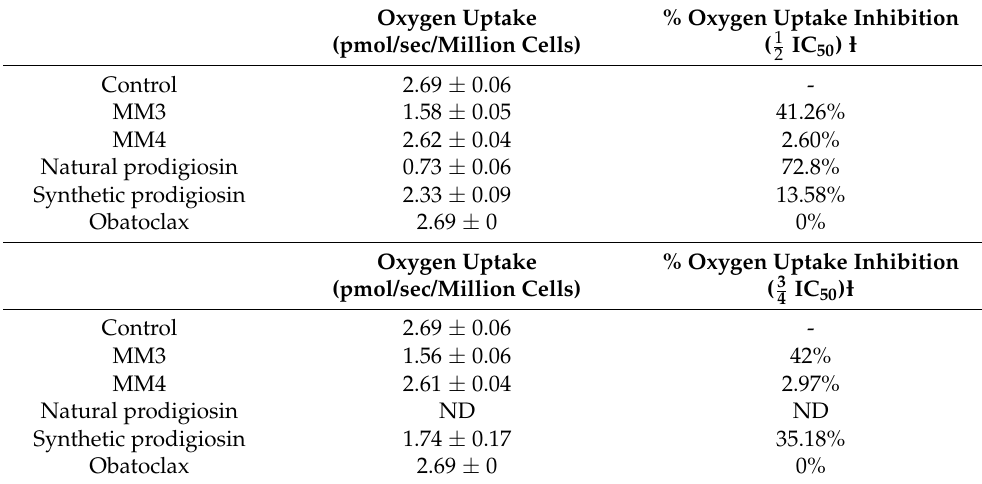
Table 7. Effect of tambjamines, Obatoclax, and synthetic and natural prodigiosins on oxygen uptake in epimastigotes.